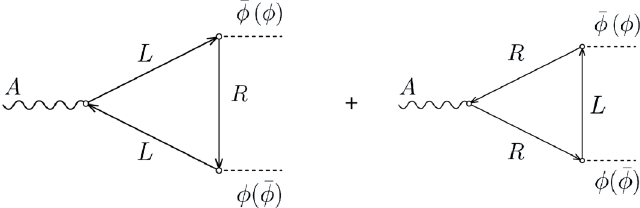
Figure 1 . Scalar anomaly cancellation (The labels in parentheses correspond to a u -quark loop). σ being the Pauli matrices (cf. appendix I of [37]); here β = iγ 0 (= β ∗ ) defines a j U(2 , 2) invariant hermitean form, so that γ ∗ mitian conjugation. The conditions (5.2) still leave a U(1) freedom γ µ → S ( ϕ ) γ µ S ( ϕ ) ∗ , S ( ϕ ) = exp( i ϕγ ) , ϕ ∈ R , in the choice of γ µ . The basis β = σ 5 2 sponds to charge conjugation matrix C = βγ posed to γ ). The two-by-two sigma matrices σ µ